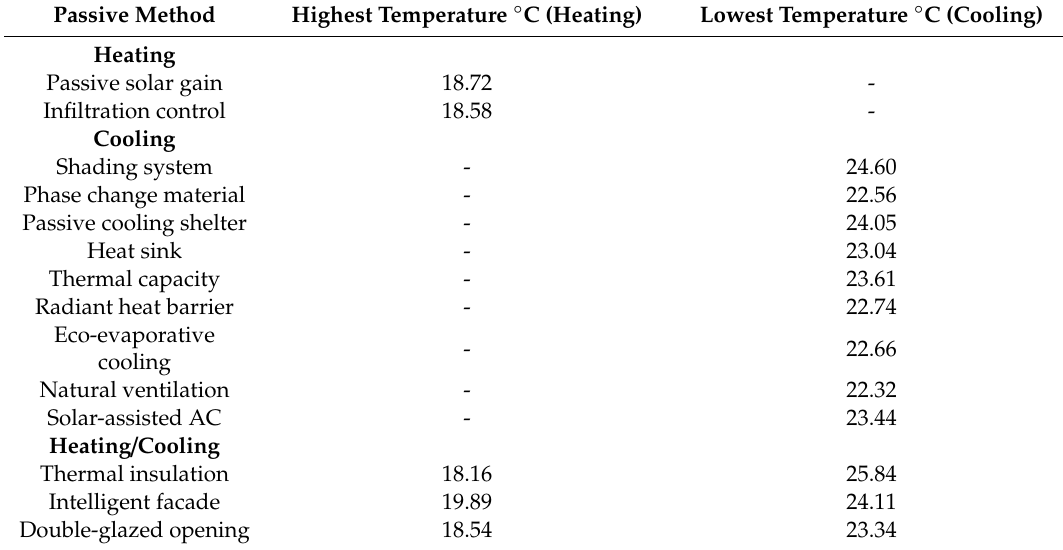
Table 8. Indoor temperature of passive cooling and heating methods with occupants